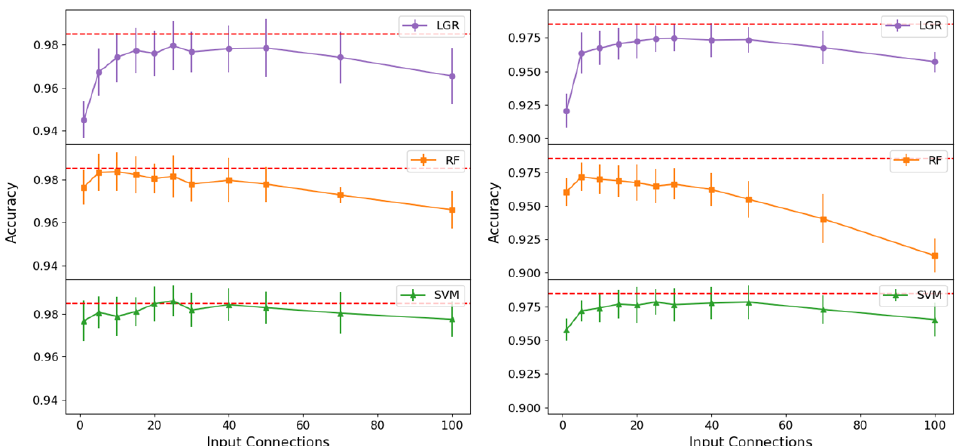
Figure 12. Soli: graphs of accuracy vs. varying C inp using 10-fold cross-validation. Results are for an LSM with 460 neurons using logistic regression, random forest, and support vector machine. The red line indicates accuracy at 98.5%. The left graph shows the results when the spike time of each sample is normalized to a common stimulus length. While the right graph when each sample has a stimulus length equivalent to the sample frame